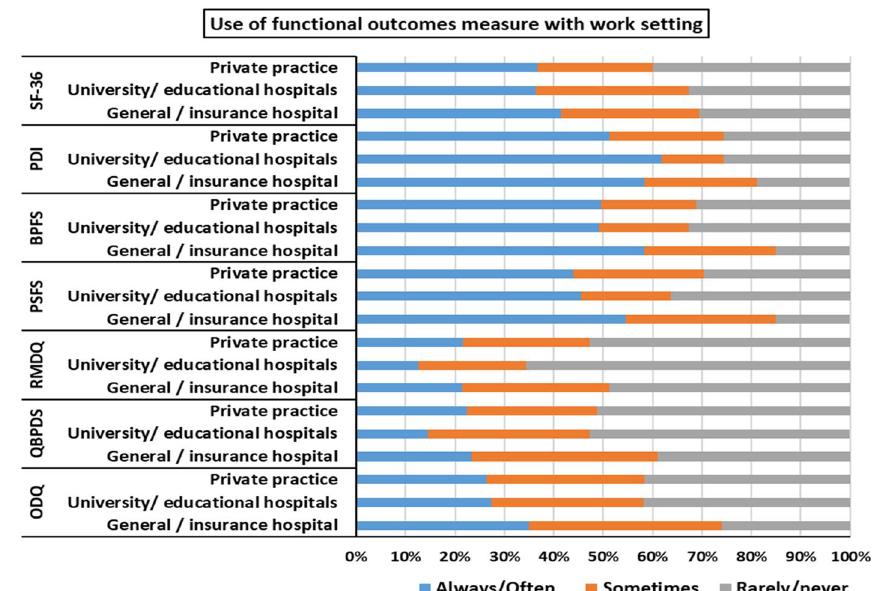
Fig. 4 The use of functional outcome measure with work